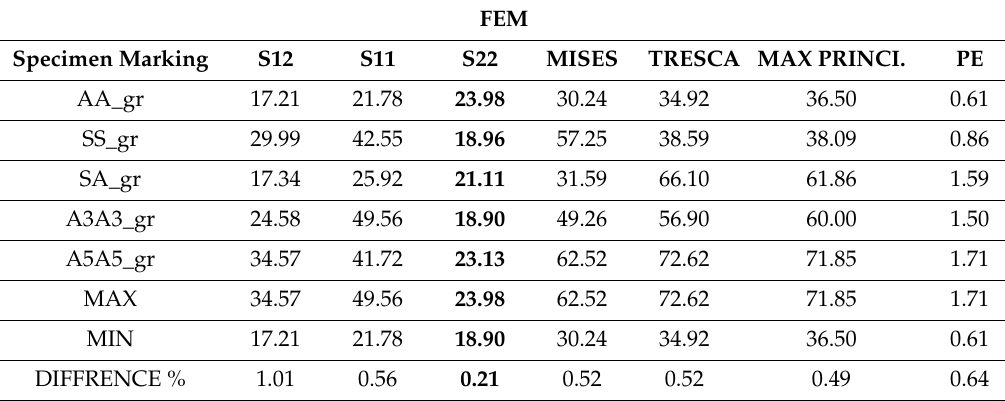
Table 8. Maximal values of the boundary layer of adhesive–element on the basis of FEM. FEM